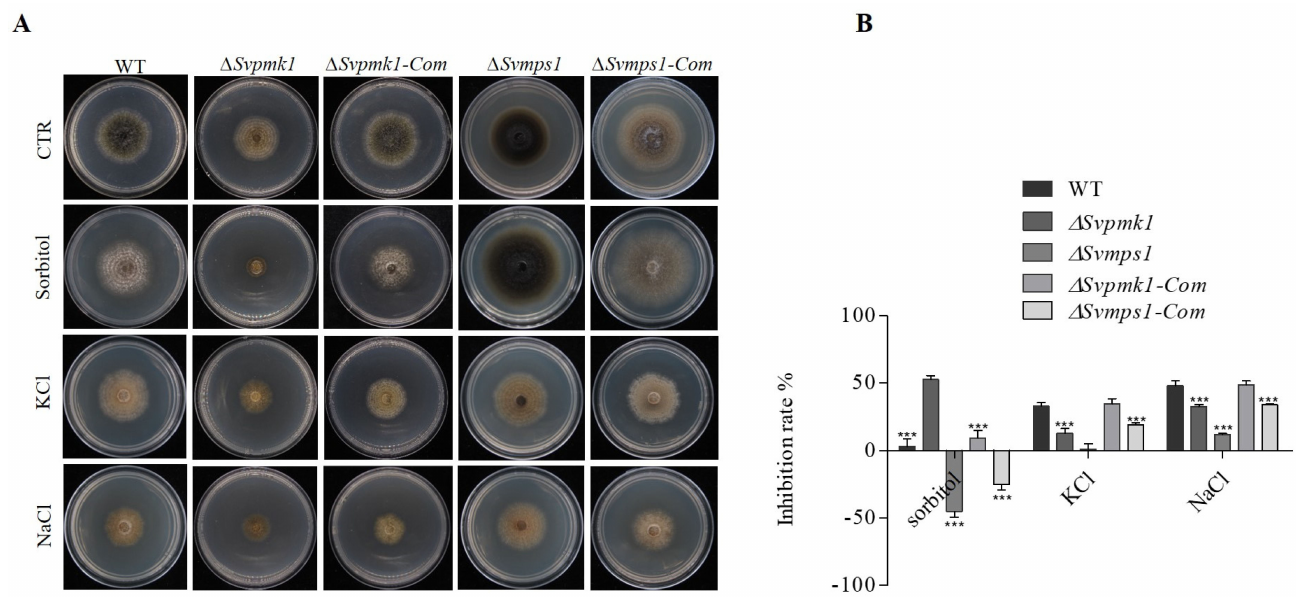
Figure 3. Roles of SvPmk1 and SvMps1 in osmotic stress tolerance in S. versabilis . ( A ) The WT, ∆ Svpmk1 , ∆ Svmps1 , ∆ Svpmk1-com and Svmps1-com were cultured on PDA supplemented with 1 M Sorbitol, KCl and NaCl and incubated at 25 ◦ C for 7 days for osmotic stress response. ( B ) Percentage inhibition of vegetative growth of the mutants relative to the WT and complementation strains. The in- hibition rate of each treatment was compared with the growth rate of the untreated control. Inhibition rate = (the colony diameter of untreated strain − the colony diameter of the treated strain)/(the colony diameter of untreated strain) × 100. Error bar represents SD from mean value of five replicates. Aster- isk = p -value (***, p < 0.001). Statistical analyses were conducted using a two-way analysis of variance (ANOVA) in GraphPad Prism 5 and Microsoft Excel spreadsheets. Similar values were obtained from three independent experimental repeats with five technical replicates for each